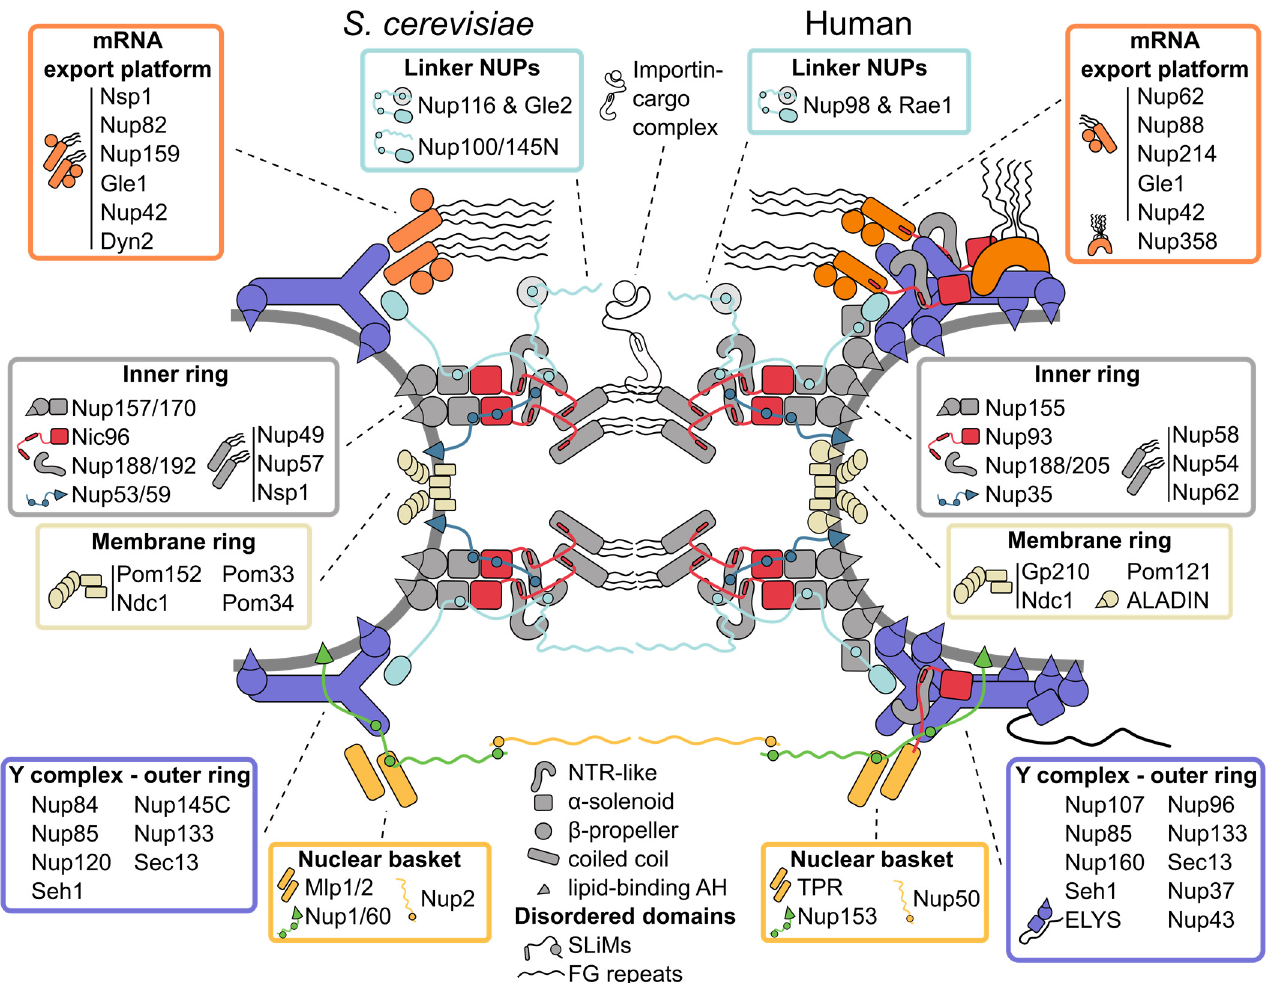
Figure 1. Inventory of the budding yeast and human nuclear pore complex . The nuclear pore complex (NPC) forms a channel connecting the nucleoplasm (bottom) with the cytoplasm (top) and is built of three concentric rings: the cytoplasmic outer ring, the inner ring, and the nucleoplasmic outer ring. The basic building blocks of the NPC are nucleoporins (NUPs), which are organized into several subcomplexes (boxes) and largely composed of only a few structural motifs (center bottom). The rigid subcomplexes are connected by disordered linkers. They contain short linear interaction motifs (SLiMs), which flexibly tie the NUPs and subcomplexes together. Multiple NUPs contain a lipid-binding amphipathic helix (AH) that helps tether the NPC to the lipid membrane. See text for details.